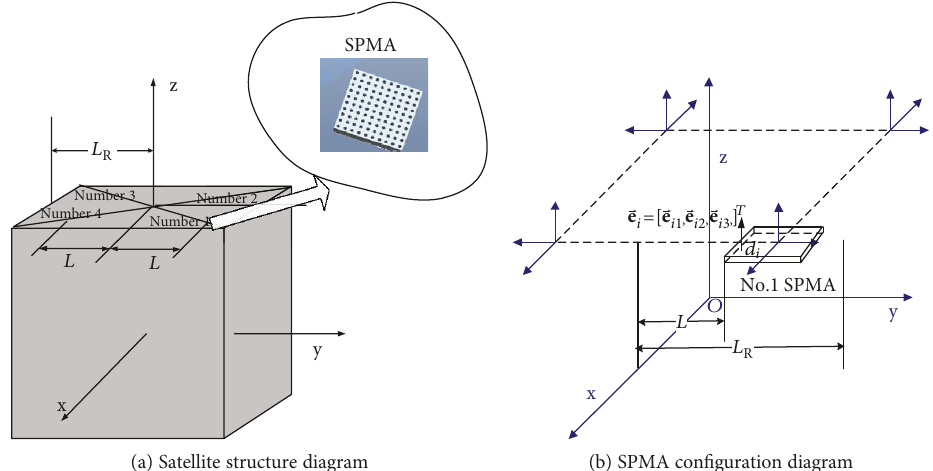
Figure 1: SPMA in the